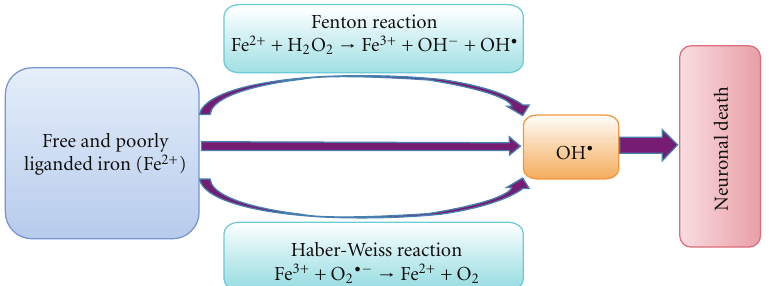
Figure 2: Generation of reactive and damaging hydroxyl radicals (OH • ). Free Iron (Fe 2+ ) reacts trough the Fenton reaction with hydrogen peroxide, leading to the generation of very reactive and damaging hydroxyl radicals (OH • ). Superoxide can also react with ferric iron in the Haber-Weiss reaction leading to the production of Fe 2+ , which then again a ff ects redox cycling. The highly reactive hydroxyl radicals lead to oxidative stress-induced lipid peroxidation, mitochondrial dysfunction, and increase in intracellular free-calcium concentration, and finally causing neuronal